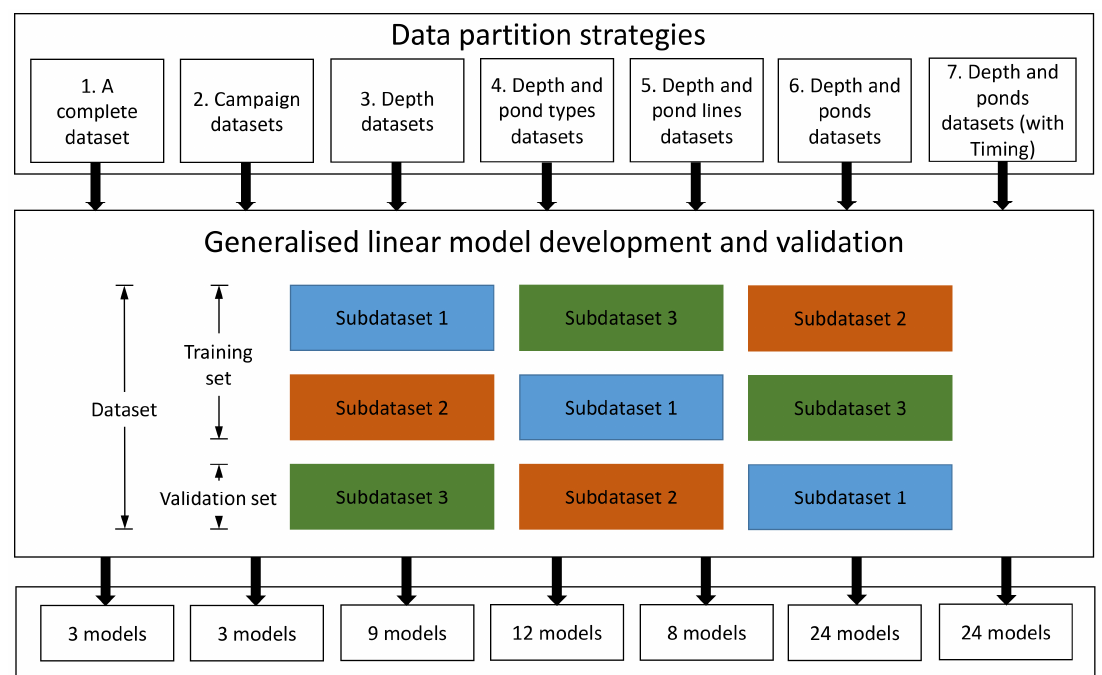
Figure 2. Schematic diagram of model development integrating different data partitioning and cross-validation strategies.